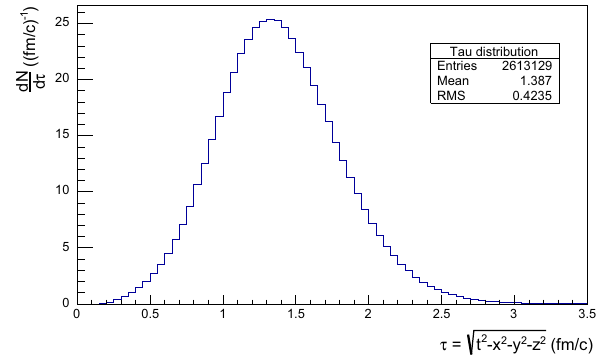
Fig. 20 Hadron number per event as a function of time for 13 TeV pp collisions